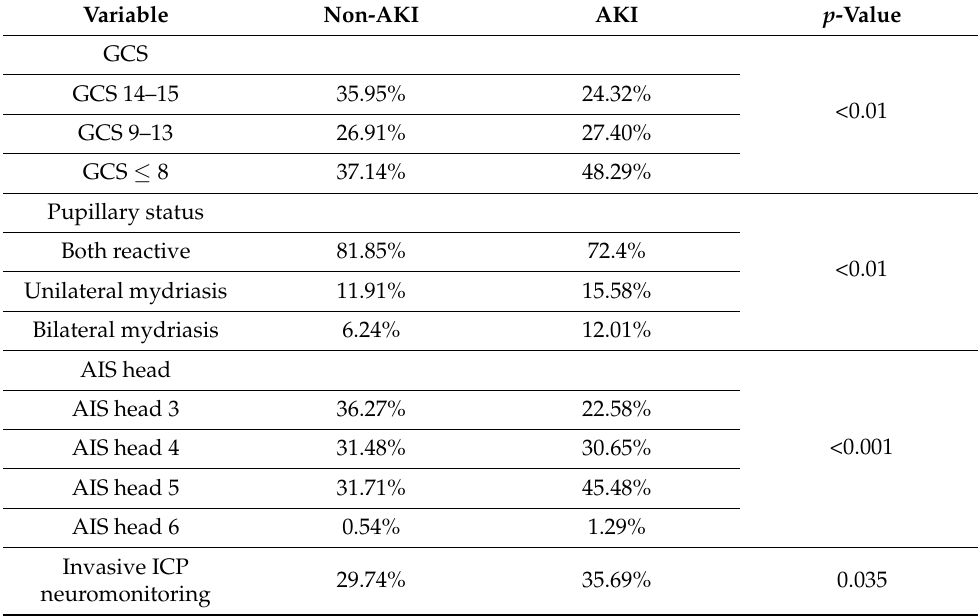
Table 1. The distribution of the severity of brain injury evaluated by the initial Glasgow coma scale, the pupillary response, the abbreviated injury scale in the anatomical head area and the need for invasive ICP neuromonitoring according to the presence of AKI.